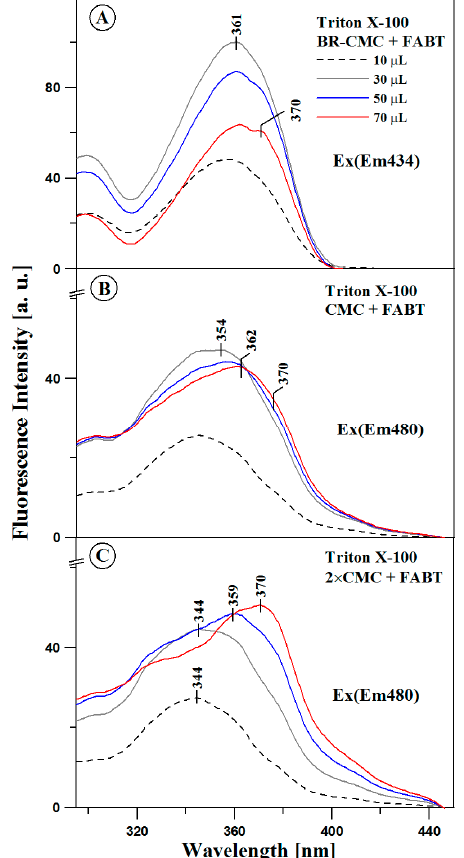
Figure 5. Fluorescence excitation spectra corresponding to emission spectra in Figure 3 (Panel A, B and C). The Ex(Em480) stands for excitation emission at 480 nm, the rest analogically. Panel ( A ) presents the results of the experiment conducted for the Triton X-100 in the amount of 10 μ L per 3 mL of the buffer (BR-CMC), Panel ( B ) for 50 μ L (CMC) of and Panel ( C ) for 100 μ L (2× CMC) of the detergent. The spectra were recorded at the temperature of 22 °C.